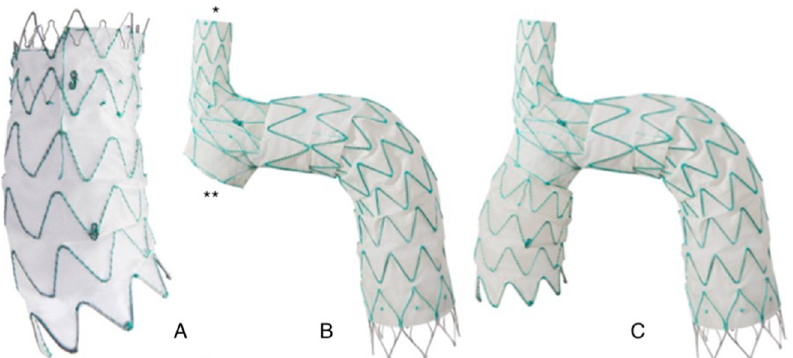
Figure 1. Nexus aortic arch system: ( A ): Ascending module. The module its pre-curved to adapt to the curvature of the ascending aorta. ( B ): Main module. The module features an integrated side branch (*) for the brachio-cephalic artery and a self-projecting sleeve (**) that faces the ascending aorta and allows connection with the ascending module. ( C ): Finally assembled device. The two modules are connected through an interlocking system that provides strong separation force reducing the risk of disconnection and of type 3 endoleak.